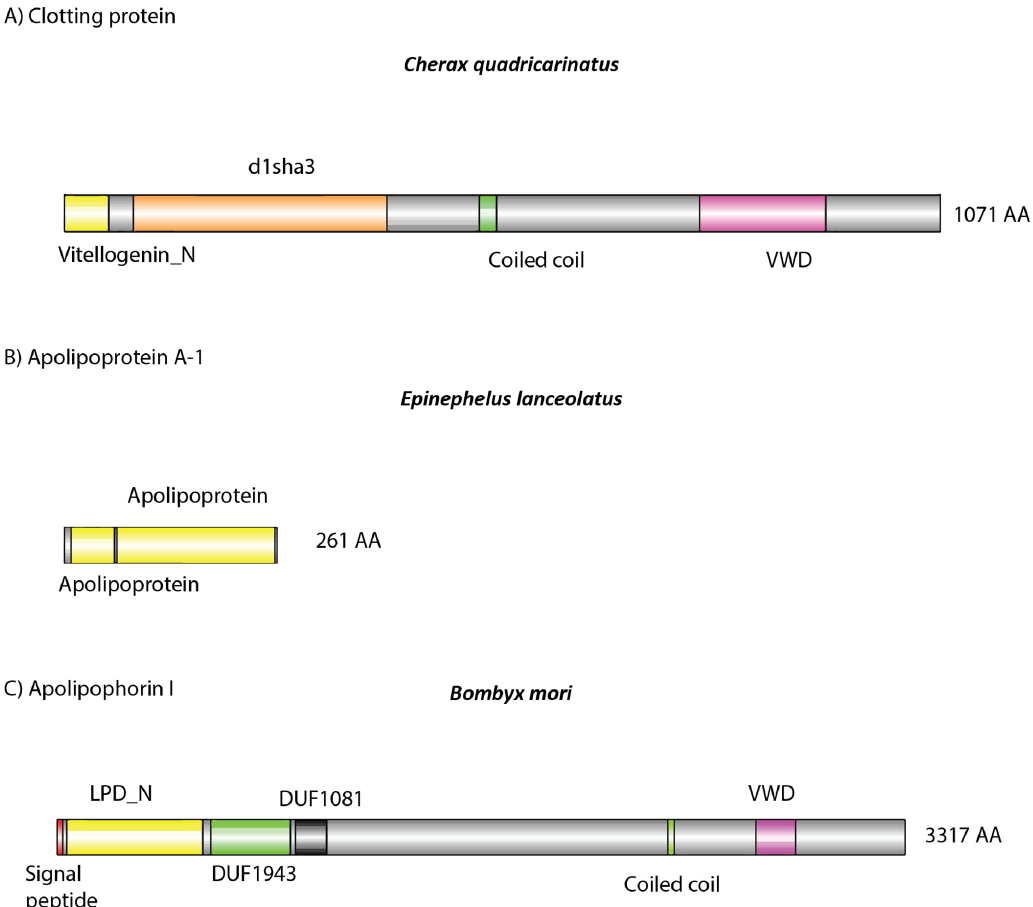
Figure 5. Domain architecture of detected putative ( A , B ) and known ( C ) dsRNA binding proteins: ( A ) identified in Cherax quadricarinatus , ( B ) in Ephinephelus lanceolatus , and ( C ) in Bombyx mori . ( A , B )